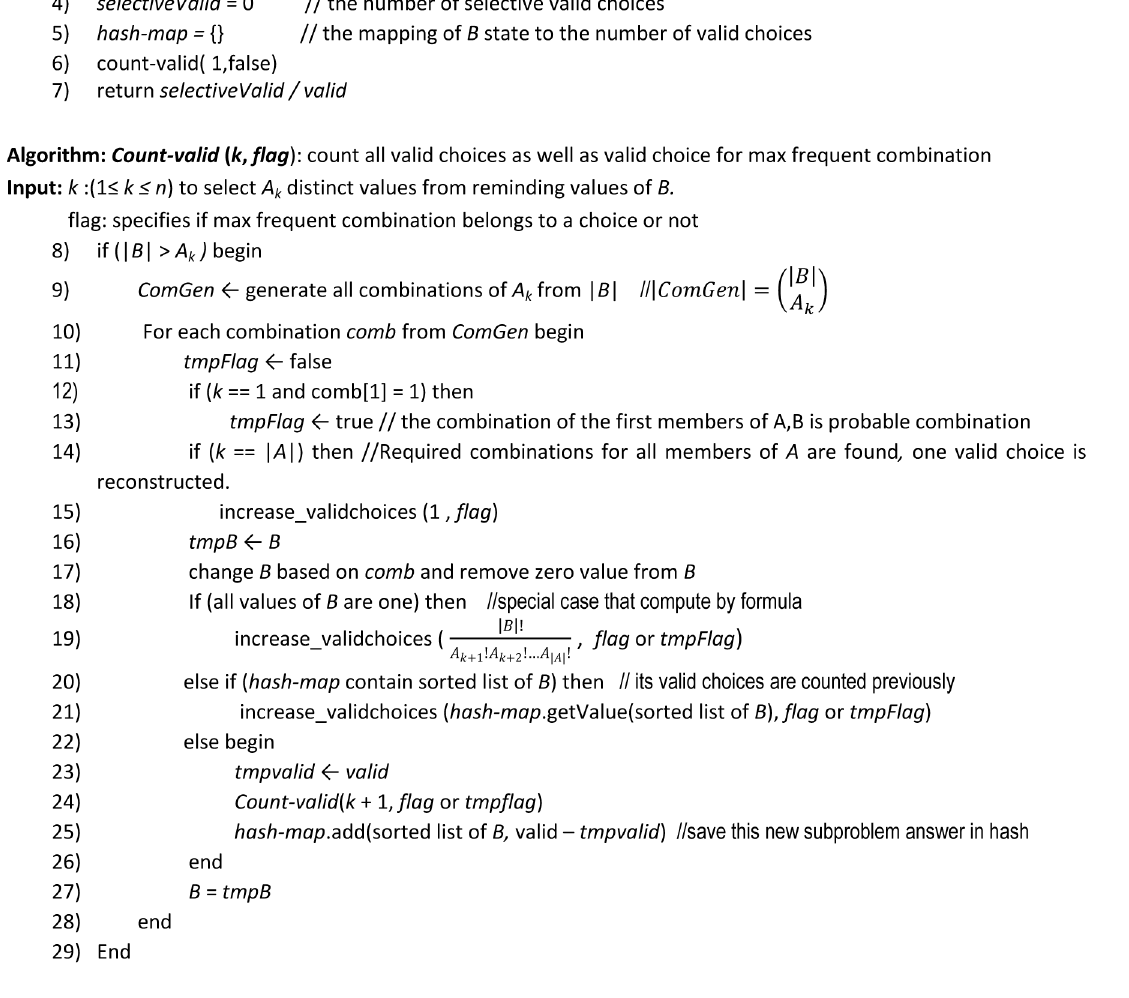
(cid:129) Last but not least, we use a dynamic programming technique to significantly reduce execution time. Values of A remain unchanged in this recursive algorithm, but B changes in each step and result is the same for all permutations of elements of B with respect to the same A . Since array A remains unchanged in the recursive function, the state of B determines the next subproblem.